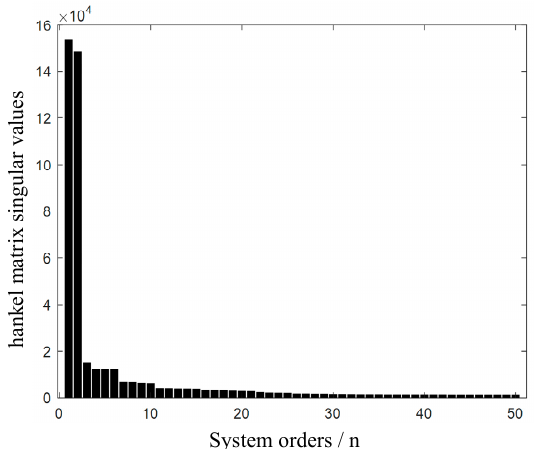
Figure 15. Modal parameter identification.